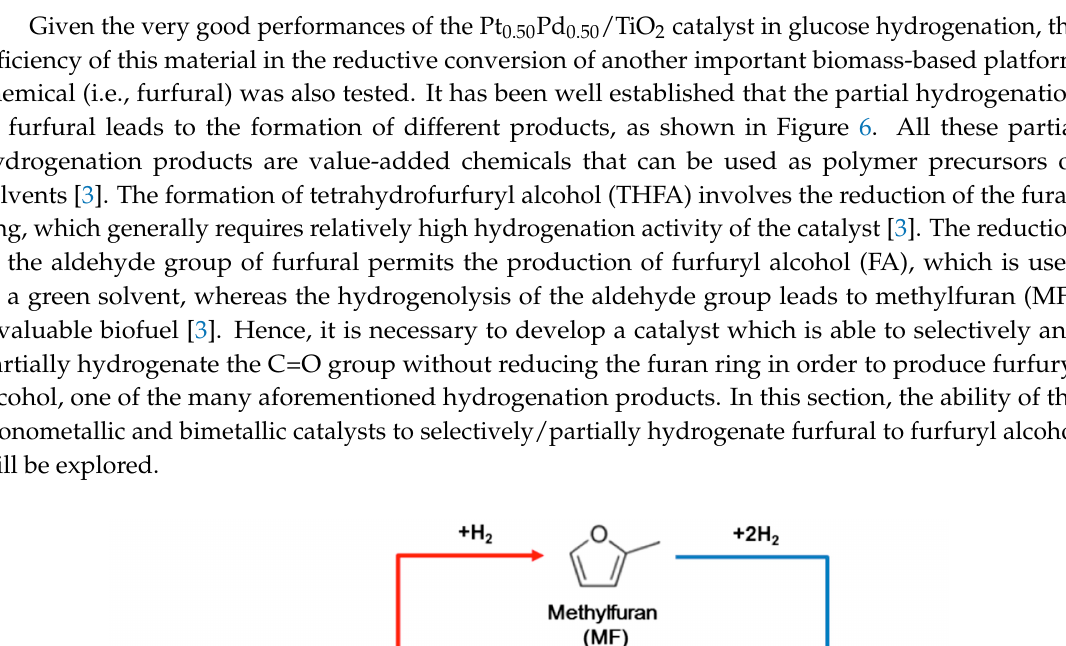
Figure 7. Furfural hydrogenation. Conditions: 2 mL of solution of furfural in isopropanol, 2 hours, 226 mass of catalyst = 10 mg, 150 °C, hydrogen pressure of 20 bar, furfural:metal ratio of 10000. 227